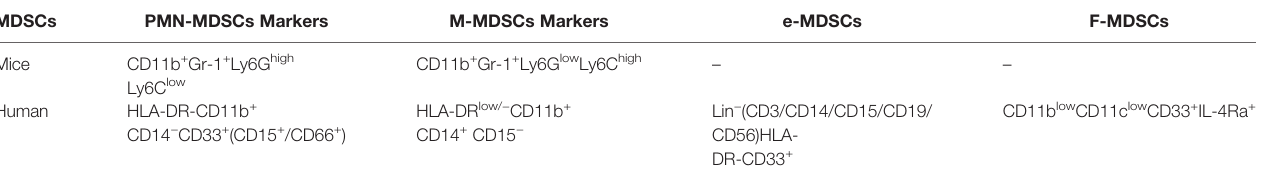
TABLE 1 | Summary of commonly expressed markers in mice and human